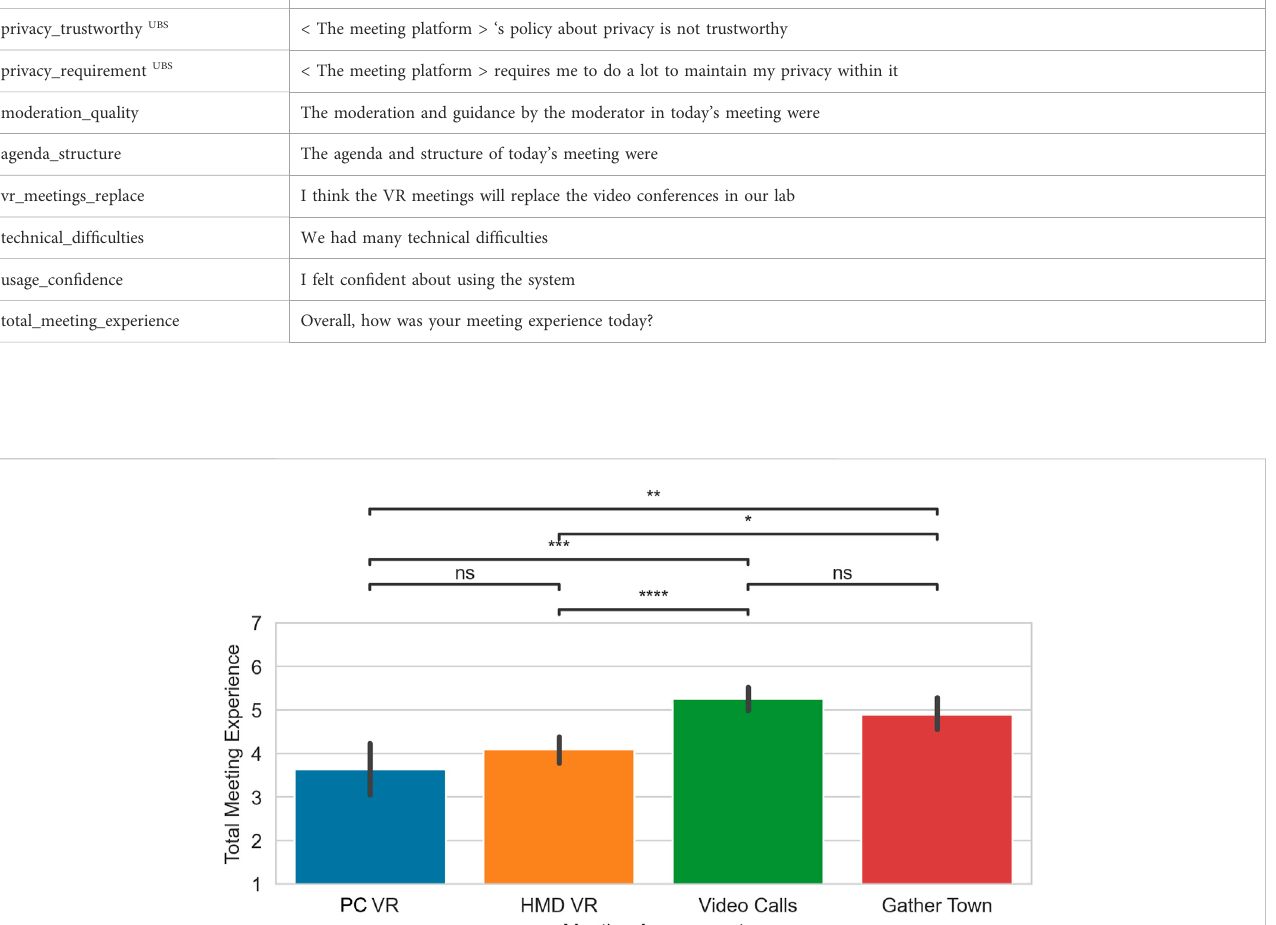
Frontiers in Virtual